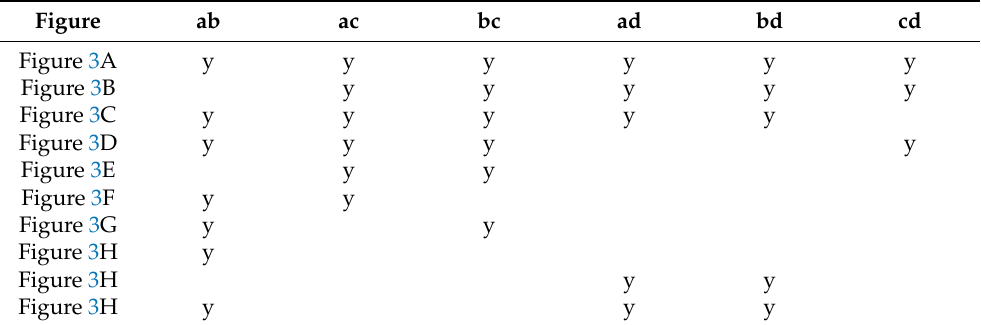
Table 2. Availability of connections between networks a, b, c and d in Figure